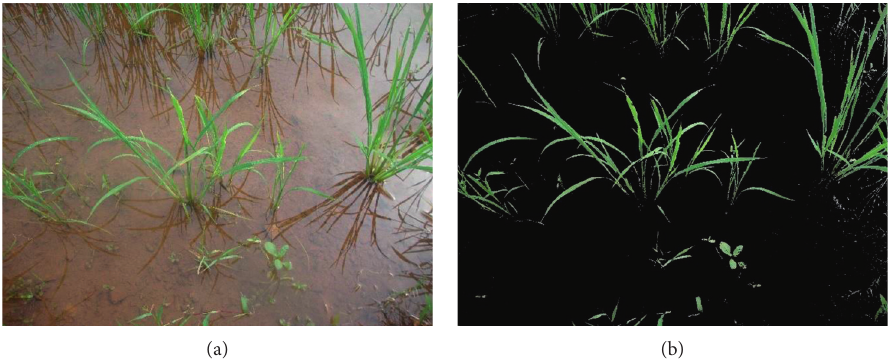
Figure 5: (a) Image taken at a distance of 1.22m from the ground using the Sony camera and (b) the corresponding background subtracted image.